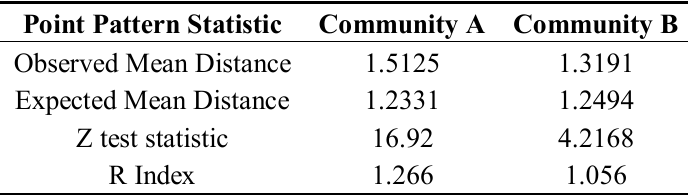
Table 6. Clark and Evans spatial point pattern test for complete spatial randomness of cells in biofilm communities A and B. Calculations are based on landscape areas defined by the convex hull of point distributions with Donnelly edge correction